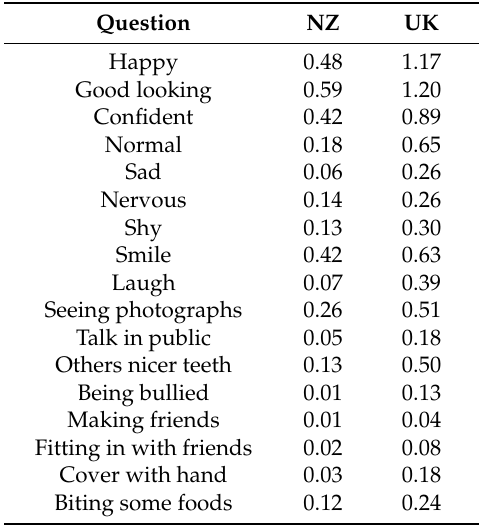
Table 5. Item-impact scores for each MIQ question (NZ, n = 64; UK, n =